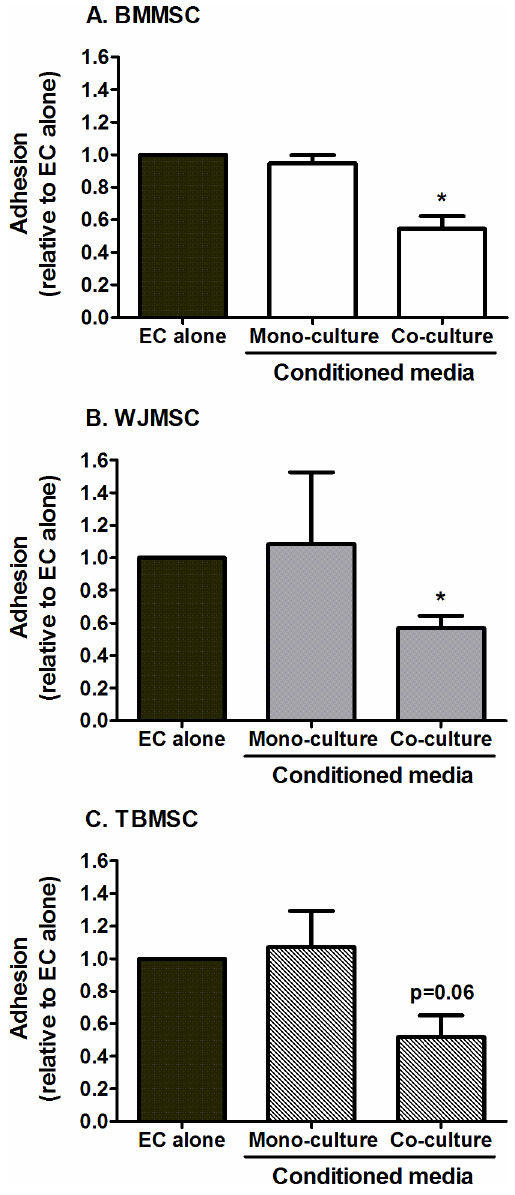
Fig 6. Effects of media conditioned by MSC alone or in co-culture with EC on neutrophil recruitment. EC mono-cultures were treated with conditioned media from BMMSC, WJMSC, or TBMSC either cultured alone or co-cultured with EC on opposite sides of filters for 24h. Not all conditions were performed in all experiments, but treated cells were always compared to paired untreated EC controls. Neutrophil adhesion was assessed at 2min post-perfusion and expressed as a proportion of that observed on the paired EC mono-culture control. ANOVA showed a significant effect of culture conditions on neutrophil adhesion for each type of MSC, p < 0.01. Data are mean ± SEM from n = 3 independent experiments using a different EC and neutrophil donor in each experiment. (A) 2 different BMMSC, (B) 3 different WJMSC and (C) 3 different TBMSC donors were used. * = p < 0.05 compared to EC cultured without conditioned media by Dunnett post-